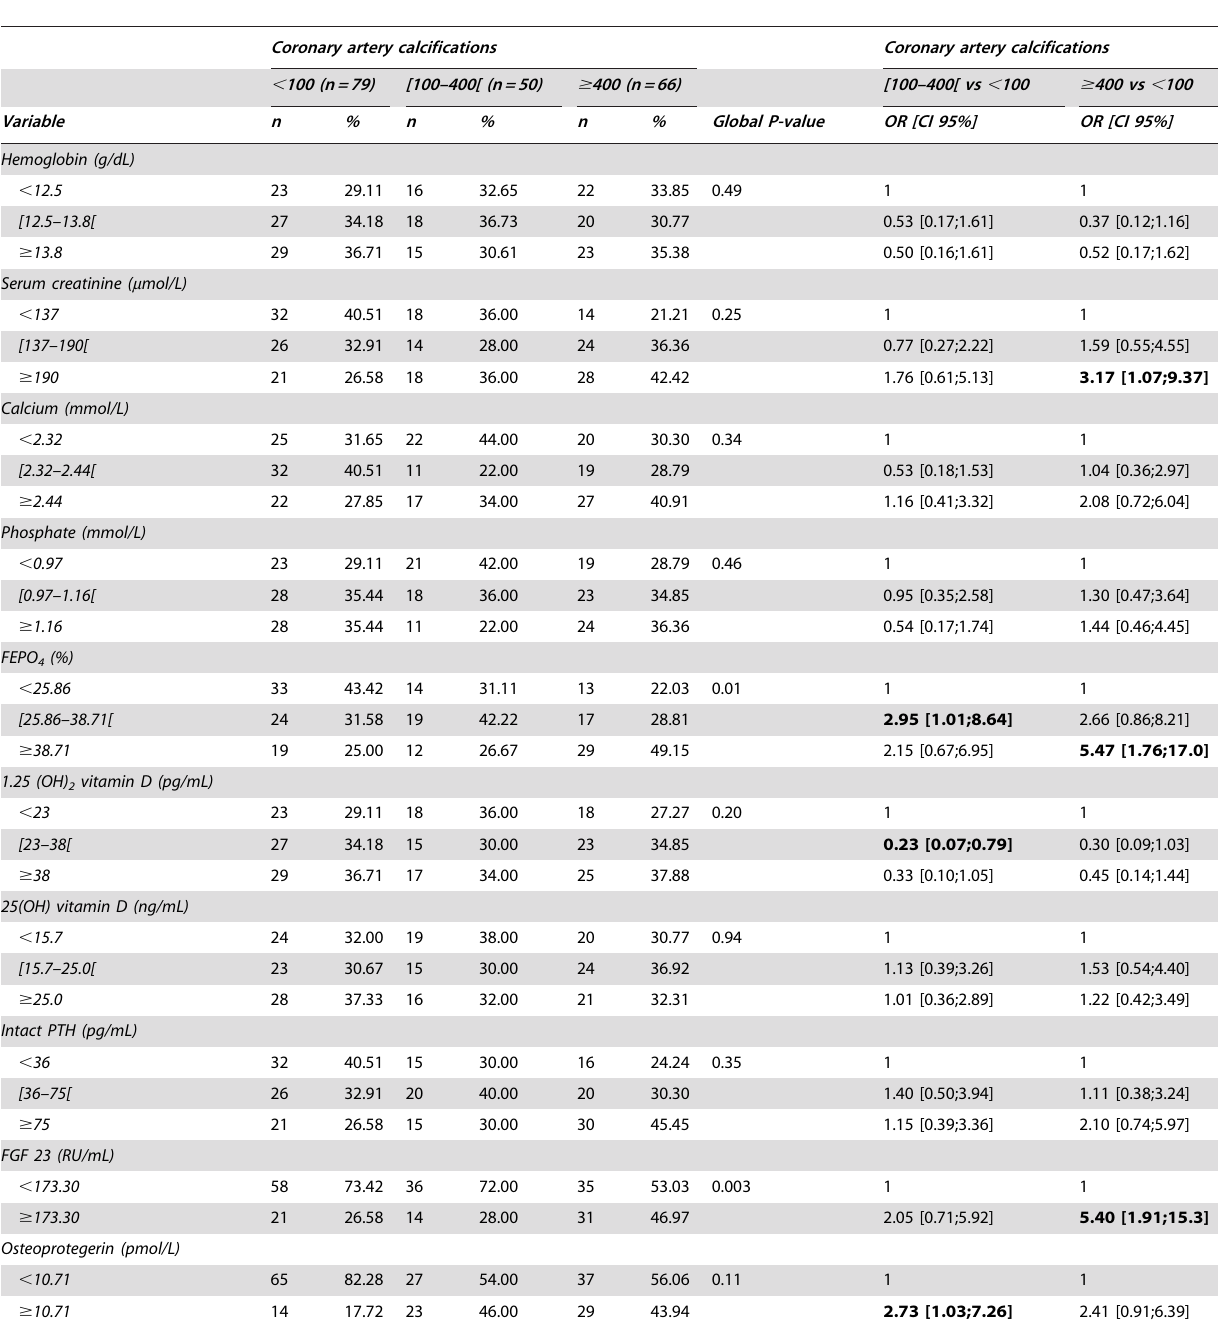
Table 3. Biological markers associated to increased coronary artery calcifications after adjustment for age, gender, diabetes mellitus and smoking (the p-value of the test for trend is